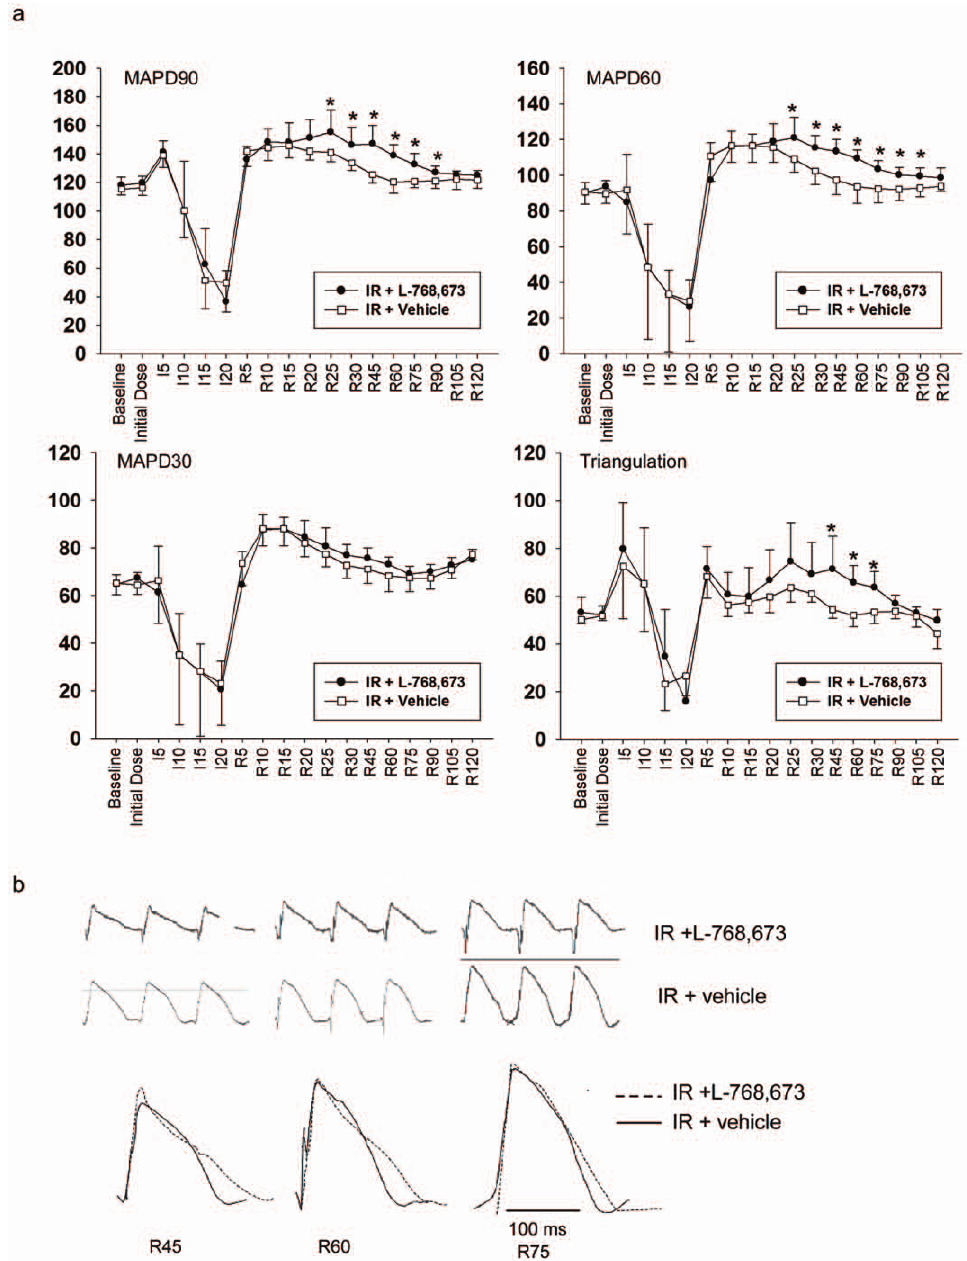
Figure 2. MAPDs, triangulations and MAP waveforms comparison between the IR + L-768,673 and IR + vehicle groups. ( A ) Epicardial MAPDs and triangulation recorded from the ischemia/reperfusion zone (apical) in the IR + L-768,673 group and the IR + vehicle group. Triangulations of the IR + L-768,673 group were increased compared with those of the IR + vehicle group by 31.1%, 26.5%, and 19.3% at R45, R60, and R75 respectively. Results are mean 6 standard deviation (STD). * P , 0.05 vs. IR + vehicle. ( B ) Comparison of monophasic action potential (MAP) waveforms between the IR + L-768,673 and IR + vehicle groups at R45, R60, and R75.